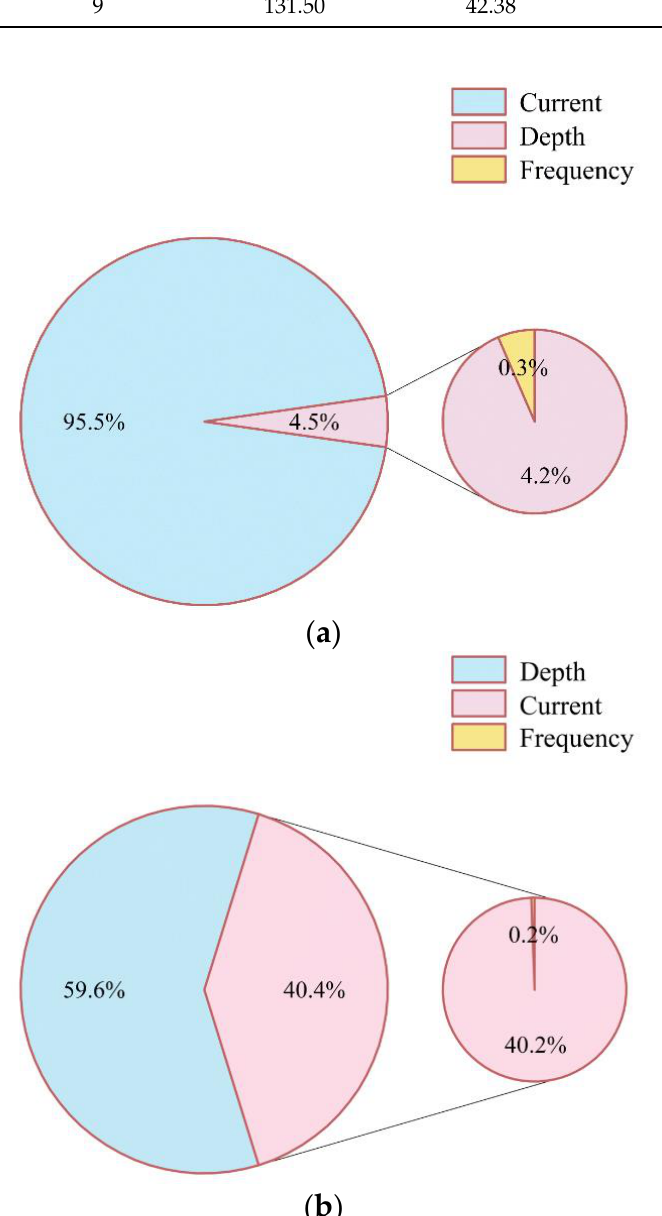
Figure 5. Percentage for the contribution rates of different factors: ( a ) contribution of each parameter to the max. mean temperature; ( b ) contribution of each parameter to temperature uniformity.